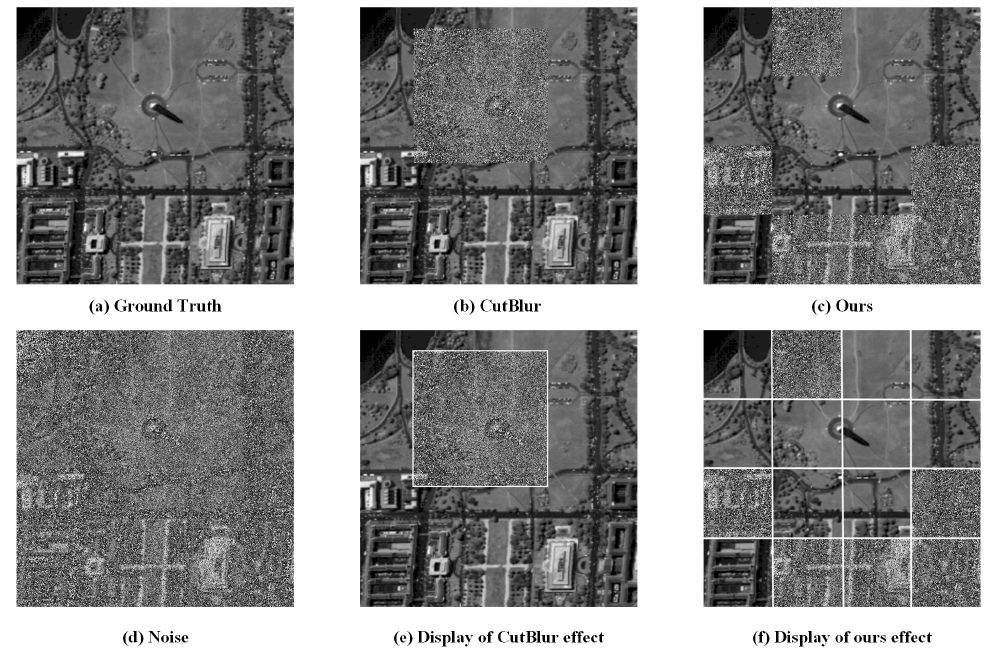
Figure 3. ( a ) is the ground truth and ( d ) is the noisy image. ( b , c ) show the renderings of different DA methods. ( e , f ) are more intuitive, using white lines to mark the part where the operation